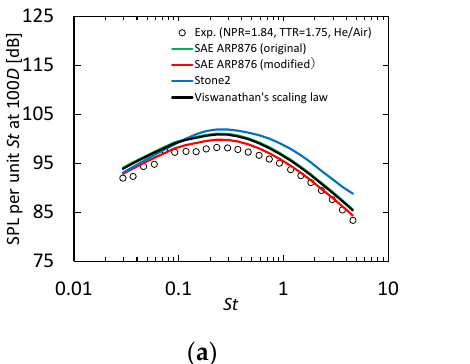
Figure 4. Experimental setup of the scale model tests for a single heat-simulated jet: ( a ) schematic diagram of JAXA’s jet noise test facility; ( b ) schematic diagram of the test nozzle.